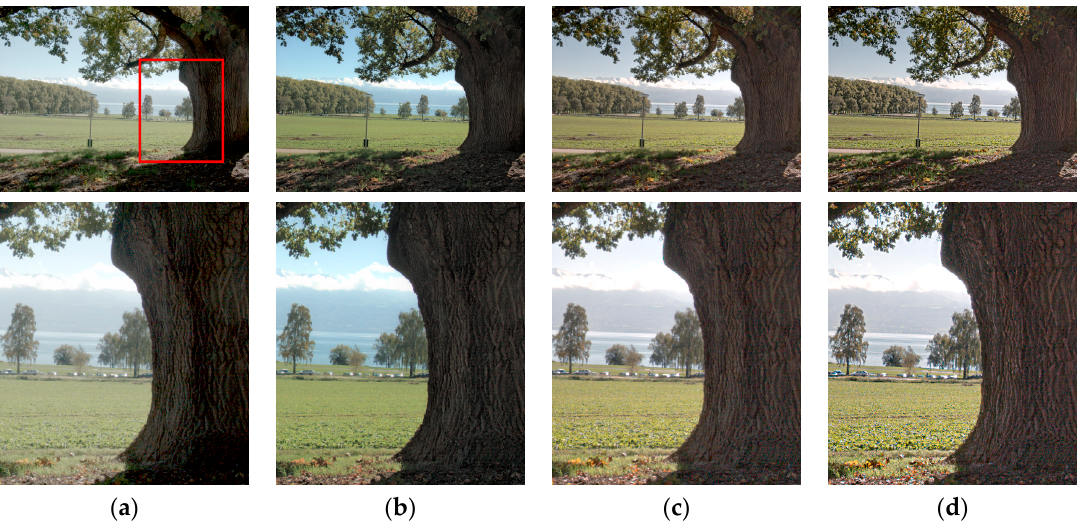
Figure 10. HDR rendered images (light box). ( a ) Reinhard (2012), ( b ) Liang (2018), ( c ) iCAM06 and (d) proposed method.